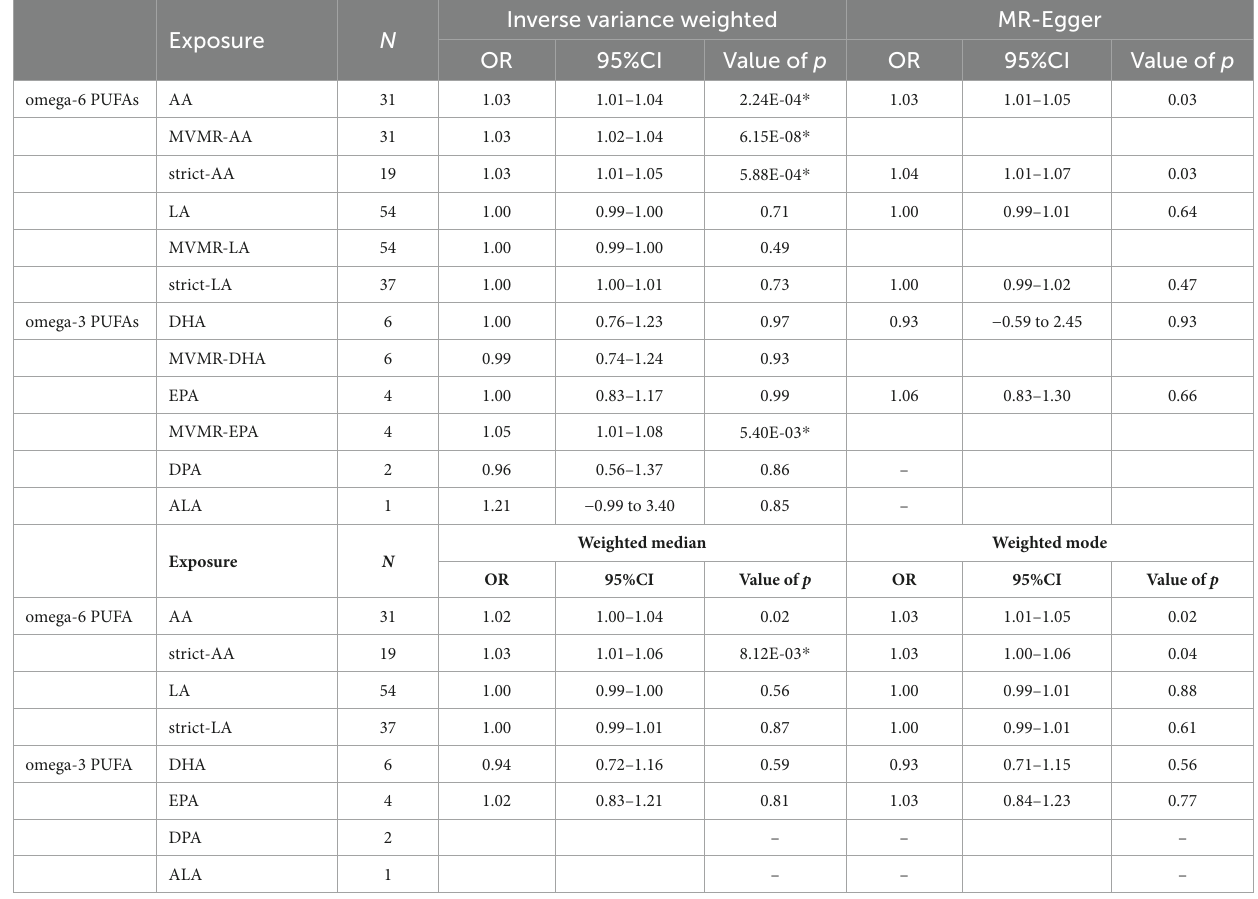
TABLE 2 MR analyses between exposures (PUFAs) and outcome (PD Risk). Inverse variance Exposure N